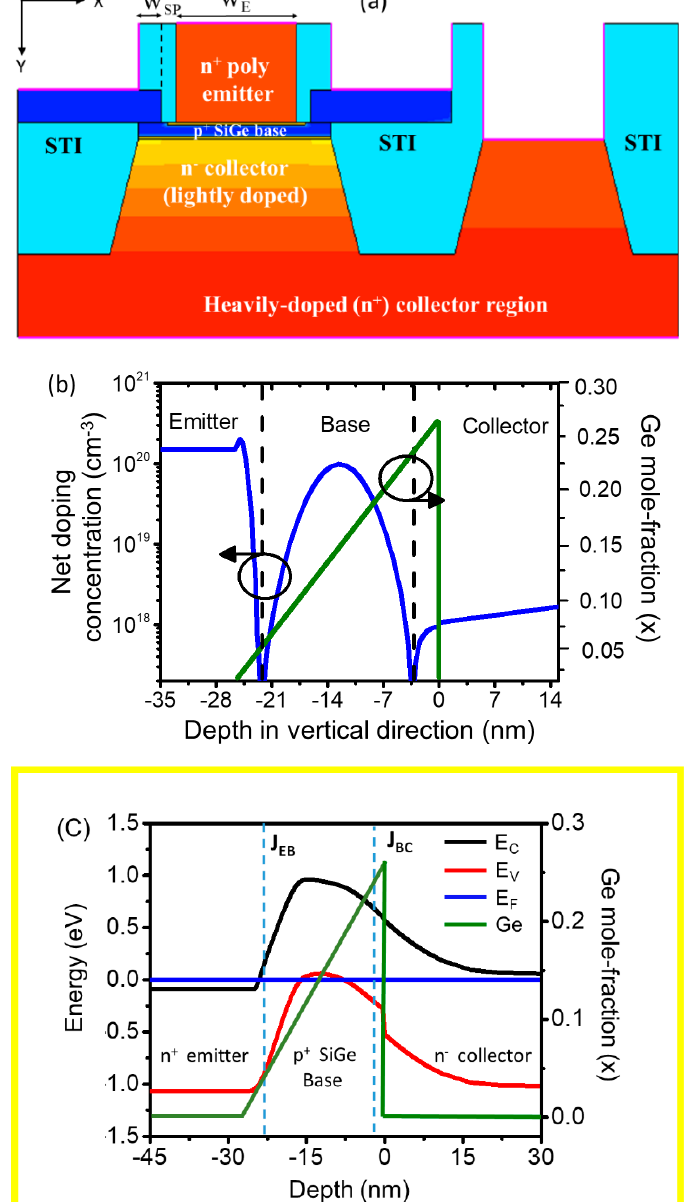
Figure 2. ( a ) A simplified 2-D schematic cross-sectional view of SiGe HBT structure; ( b ) Shows net doping concentration of the device intrinsic region and linearly graded germanium profile (5% at the EB junction and 23% at the CB junction); ( c ) equilibrium energy band diagram of n − p − n SiGe HBT with Ge profile.